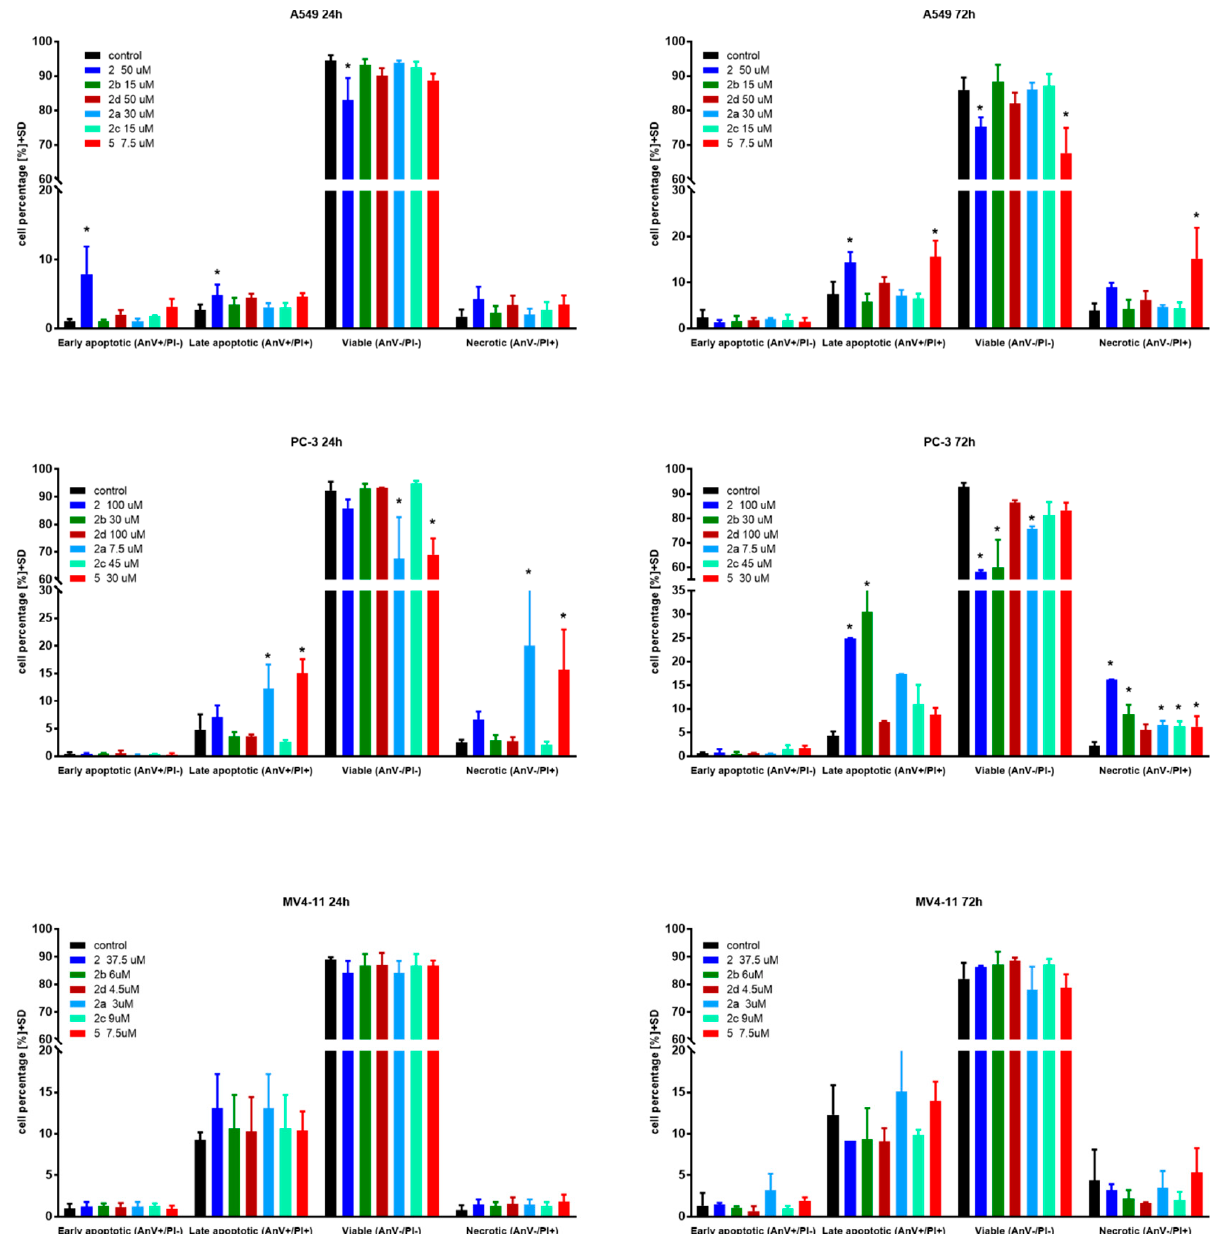
Figure 2. Induction of apoptosis by tested compounds after 24 and 72 h. * statistically significant versus control cells, p < 0.05. Compounds were used in concentrations of about 1.5 × IC 50 . In the case of the A549 lung carcinoma cell line after 24 h incubation time, one com- pound 2 showed significantly increased levels of early-apoptotic and apoptotic cells at the expense of the living cell population. As expected, longer treatments shifted the ratio towards apoptotic and necrotic cells. Additionally, after 72 h incubation time, compound 5 exhibited significantly upraised levels of apoptotic and necrotic cells compared to the control. A similar effect was observed on the PC-3 cell line after 24 h incubation with deriva- tives 2 , 2a and 5 . After 72 h incubation time, almost all compounds caused a